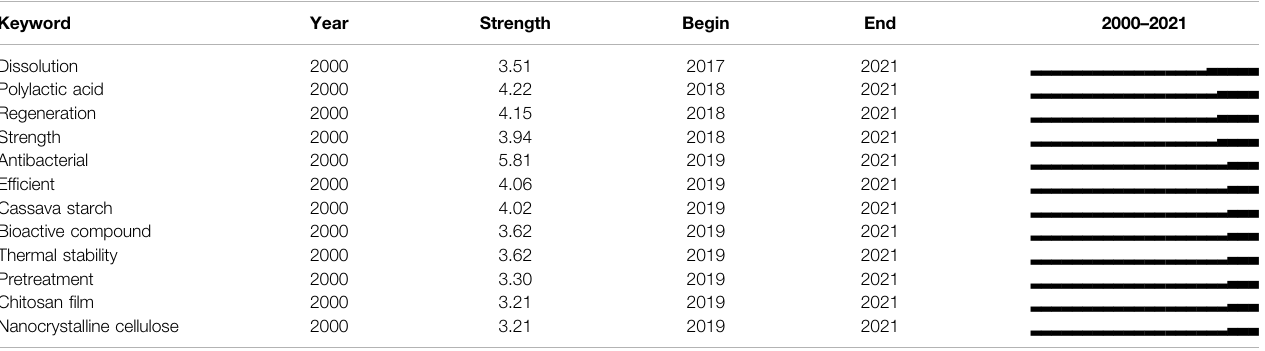
TABLE 6 | Top 25 keywords with strongest citation